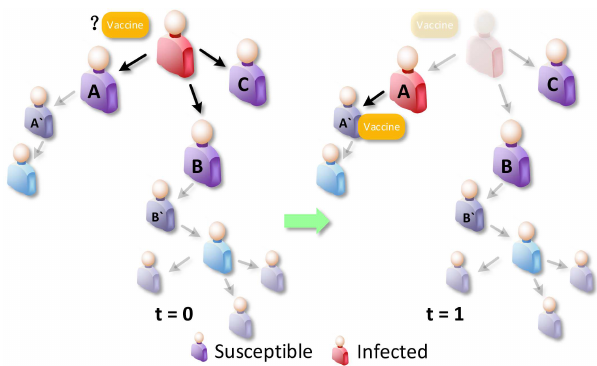
Figure 1. Different benefit of position over each placement time.